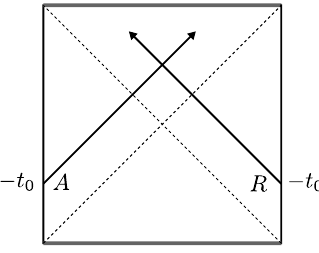
Figure 2 . A two-sided AdS black hole. The causal structure appears to suggest that two signals A; R will encounter each other inside the black hole. This, however, leads to non-locality on the